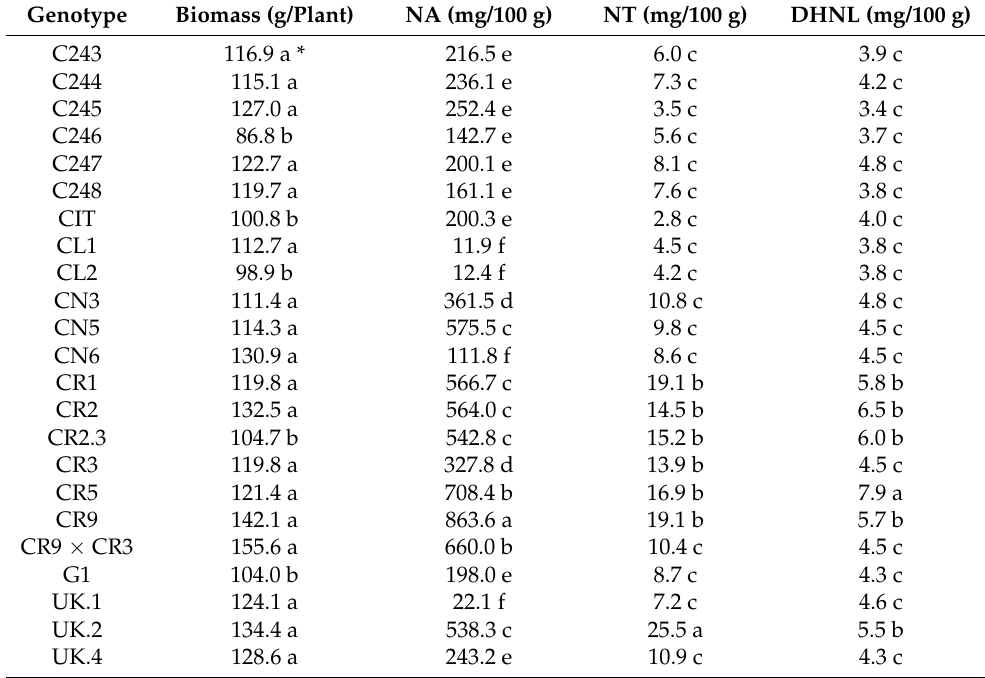
Table 2. Average biomass yield and nepetalic acid (NA), nepetalactam (NT) and dihydronepetalactone (DHNL). content in catnip